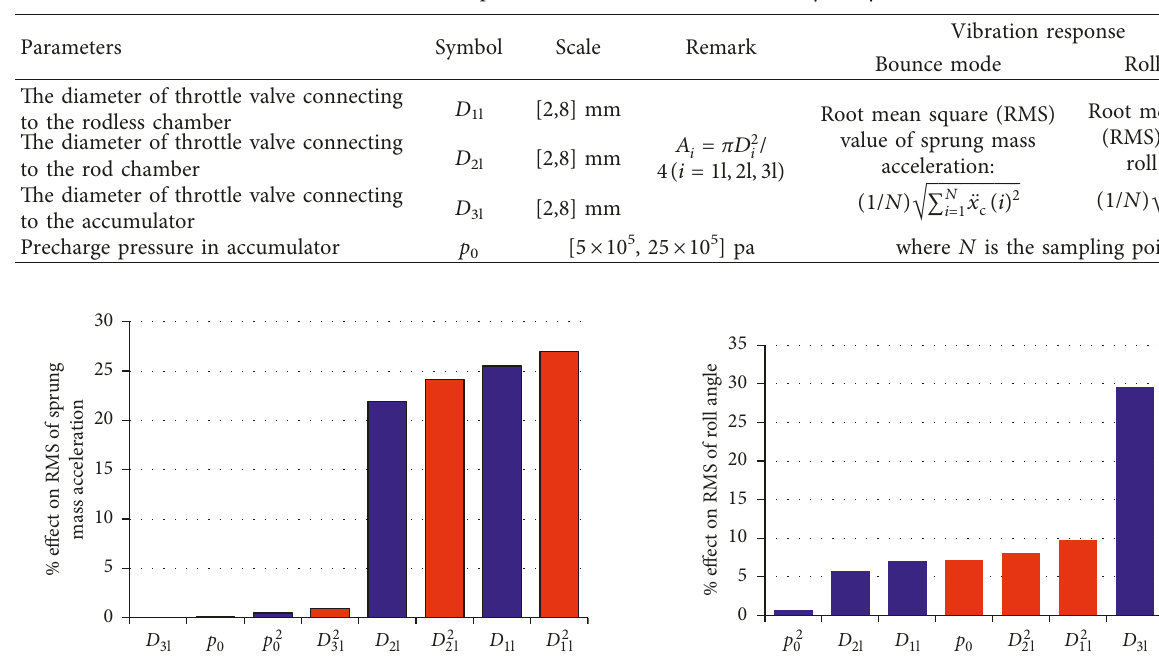
Figure 4: Comparisons between simulation and experimental test. (a) Sinusoidal displacement excitation for bounce modal. (b) Hydraulic force for bounce modal. (c) Indicator diagram for bounce modal. (d) Sinusoidal displacement excitation for roll modal. (e) Hydraulic force for roll modal. (f) Indicator diagram for roll modal. Table 2: Experimental test scheme for sensitivity analysis.